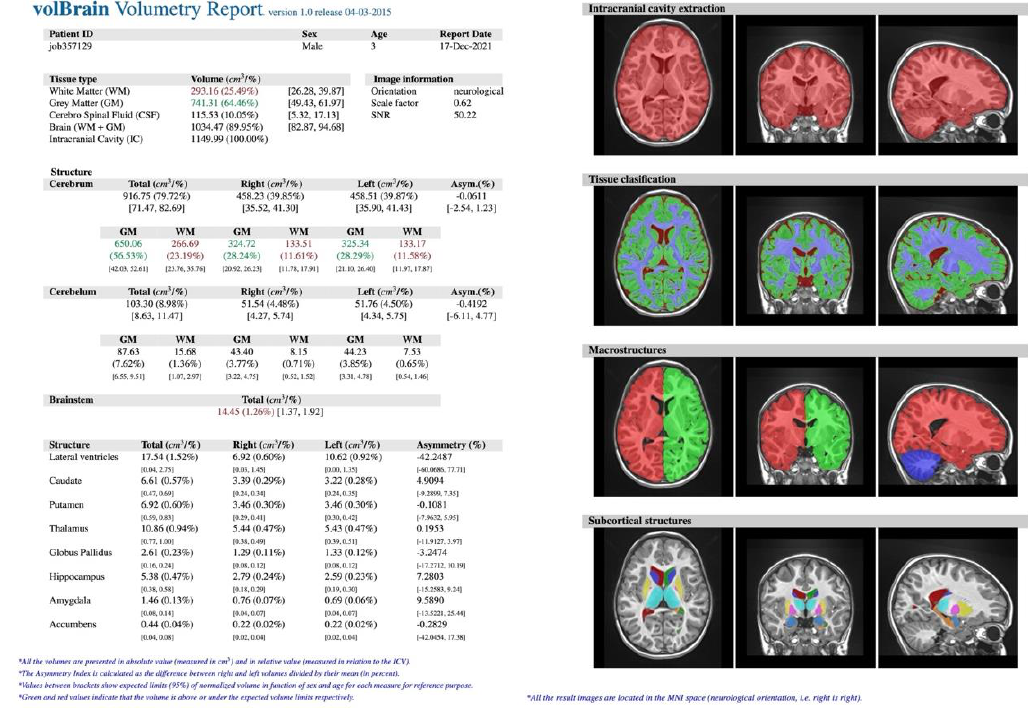
Figure 5. VolBrain analysis of head MR of a 3 − year − old boy. Source: own study.